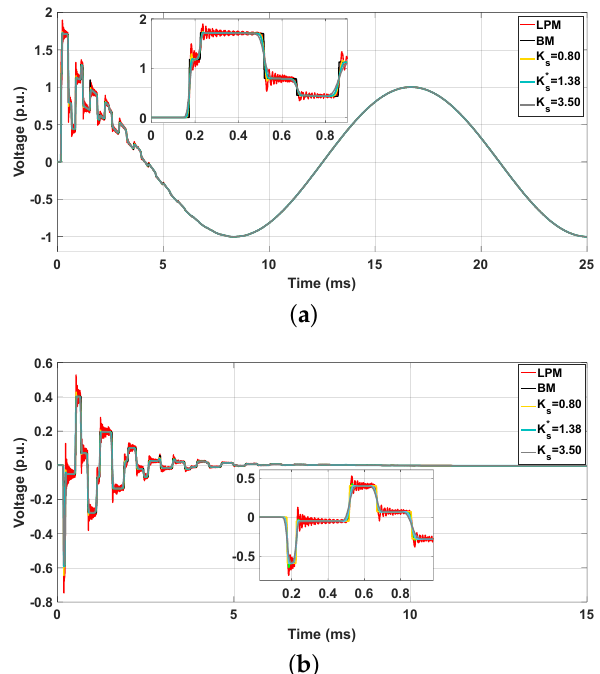
Figure 15. V m ( t ) in Scenario 4 obtained with the LPM, T 2 and BM with K ∗ s : ( a ) Phase 1 ( b ) Phase 2 (or Phase 3).